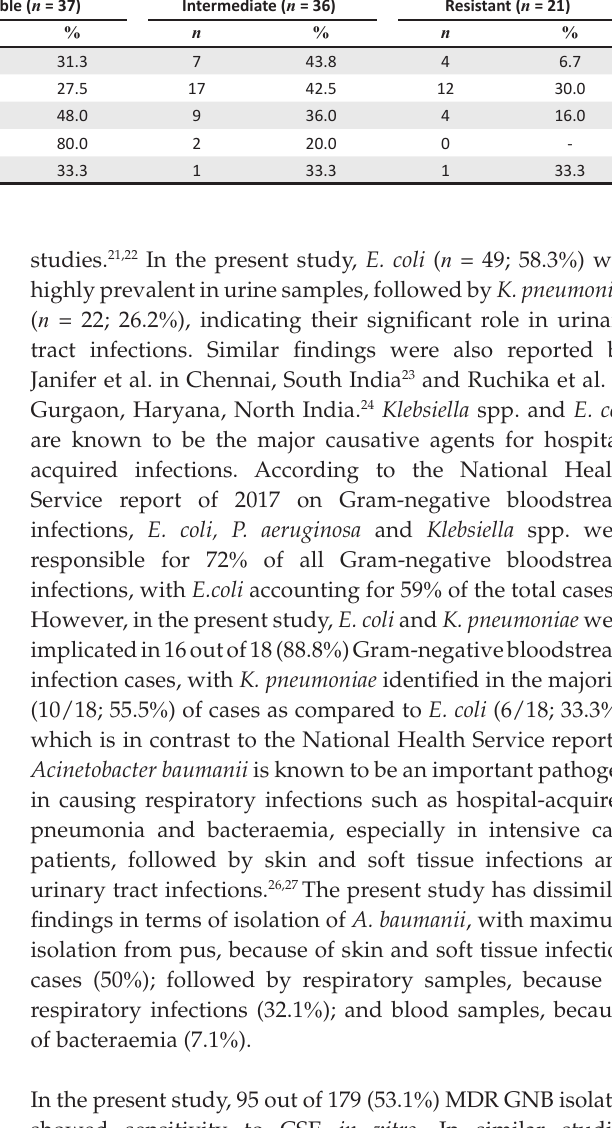
TABLE 3: Antibiogram for ceftriaxone-sulbactam-disodium edetate against metallo β -lactamases producing Gram-negative isolates at a hospital in Delhi, India, February 2017 to June 2017.